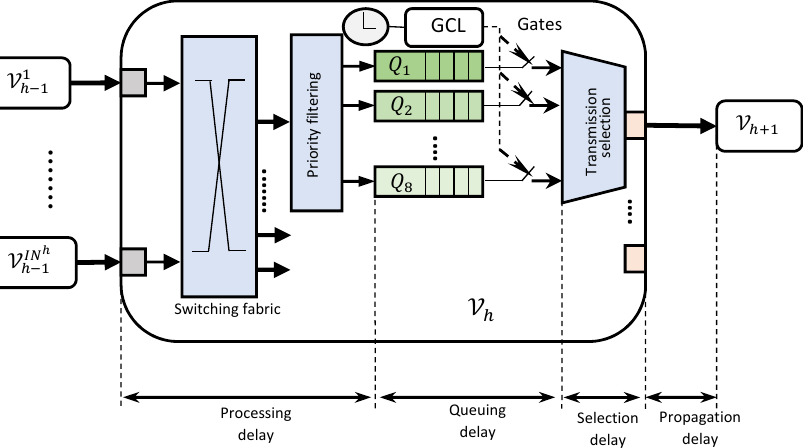
Figure 2. An IEEE 802.1Qbv capable switch with multiple input and output ports, showing delay components between adjacent nodes.